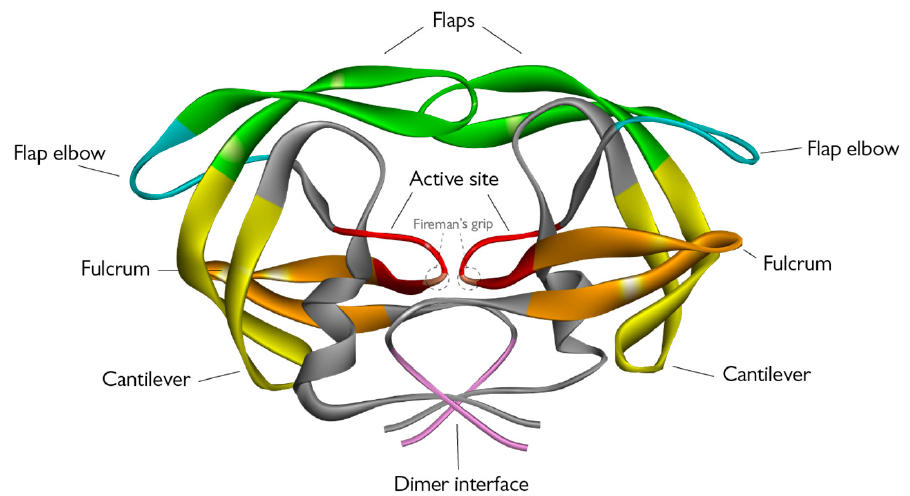
Figure 3. 3D structure of HIV-1 PR (PDB ID 6O48) visualized as a ribbon diagram with functional domains highlighted in different colors [34]: protease flaps in green, flap elbows in turquoise, fulcrum in orange, cantilever in yellow, dimer interface in pale magenta, and active site in red.